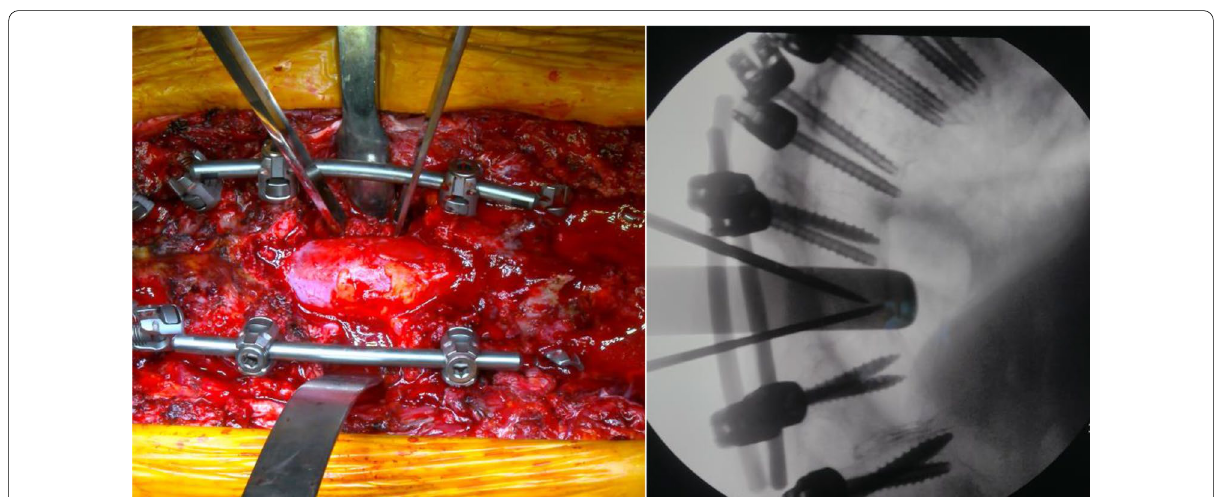
Fig. 4 Surgical and radiographic pictures of the first PSO, performed at T12 using a bone